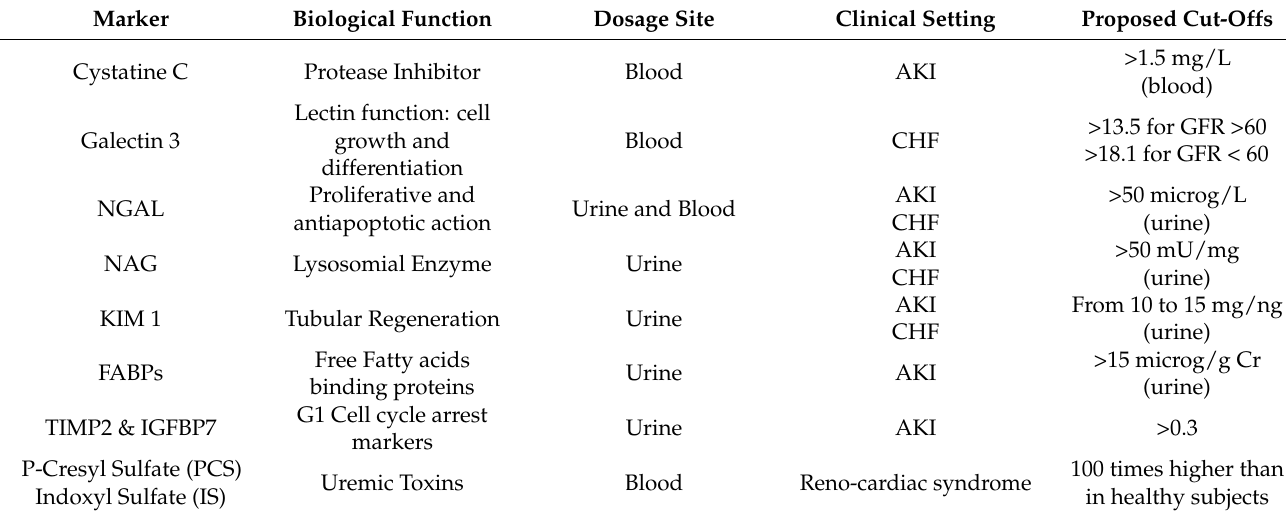
Table 1. Characteristics of the main renal biomarkers indicative of cardiorenal and renocardiac syndrome progression. Marker